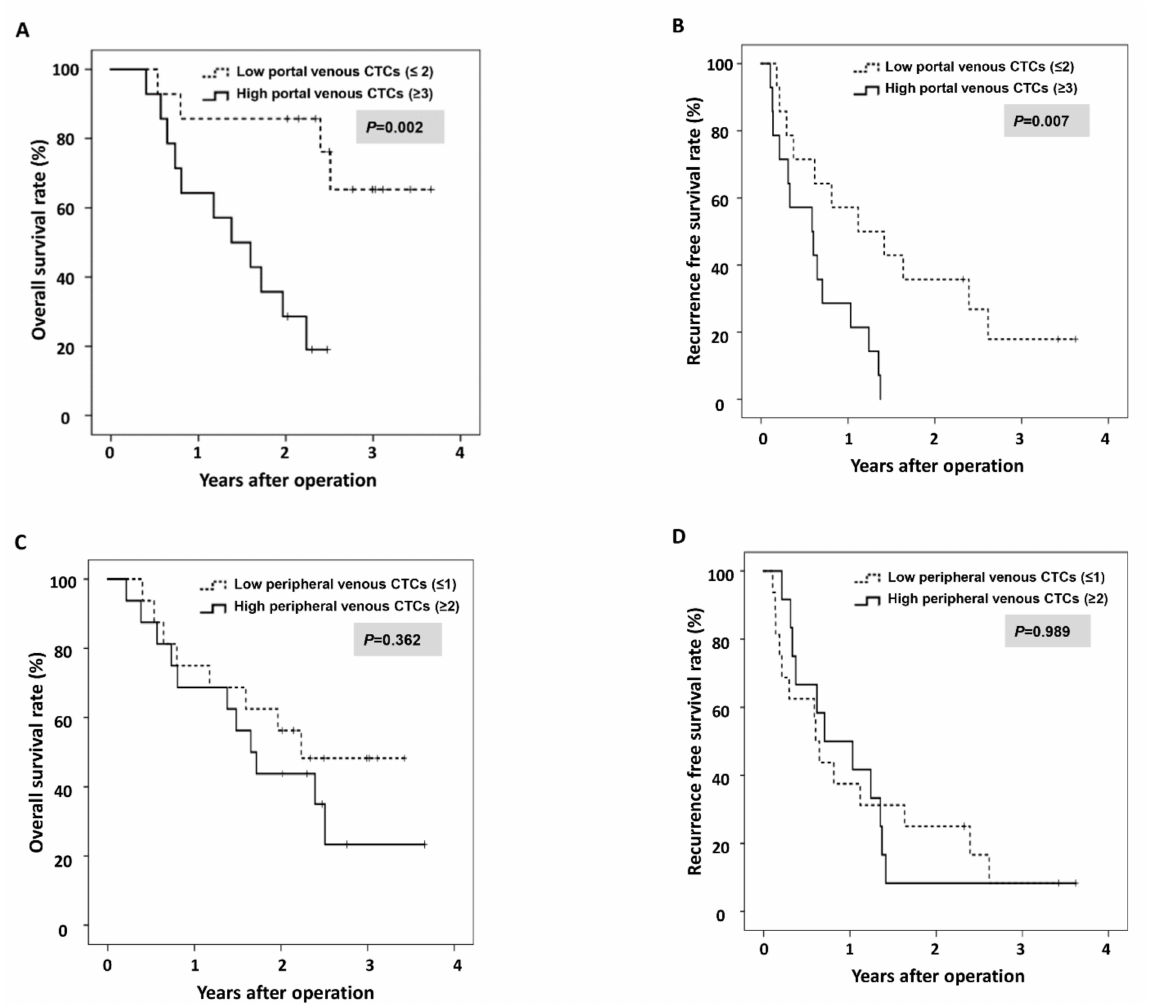
Figure 4. Survival analyses in patients by level of CTCs. ( A , B ) Kaplan–Meier survival analy- sis showed that patients with low portal venous CTC ( ≤ 2) had better overall survival (OS) and progression-free survival (PFS) compared with those with high portal venous CTCs ( ≥ 3) ( p = 0.002 and p = 0.007, respectively). ( C , D ) The number of peripheral venous CTCs was not associated with OS and RFS after resection of pancreatic